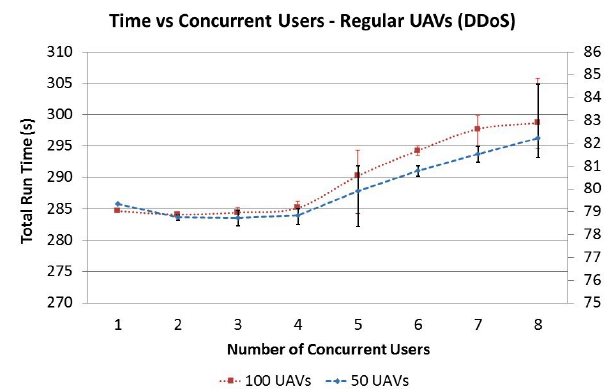
Figure 6. Run time variation of security simulation with increasing number of concurrent users in server mode operation for DDoS